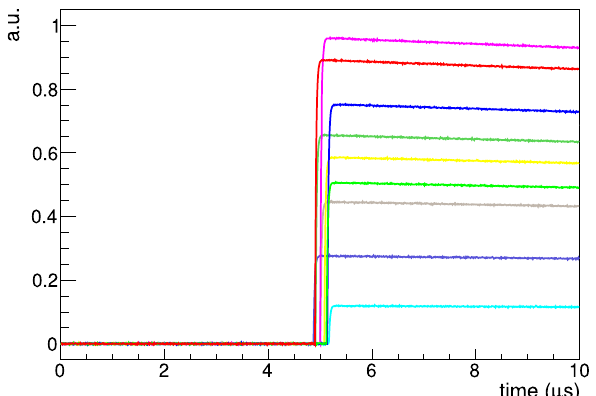
Fig. 3 A subset of the simulated detector signals in the simplified case of Eq. (21), for T max = 500